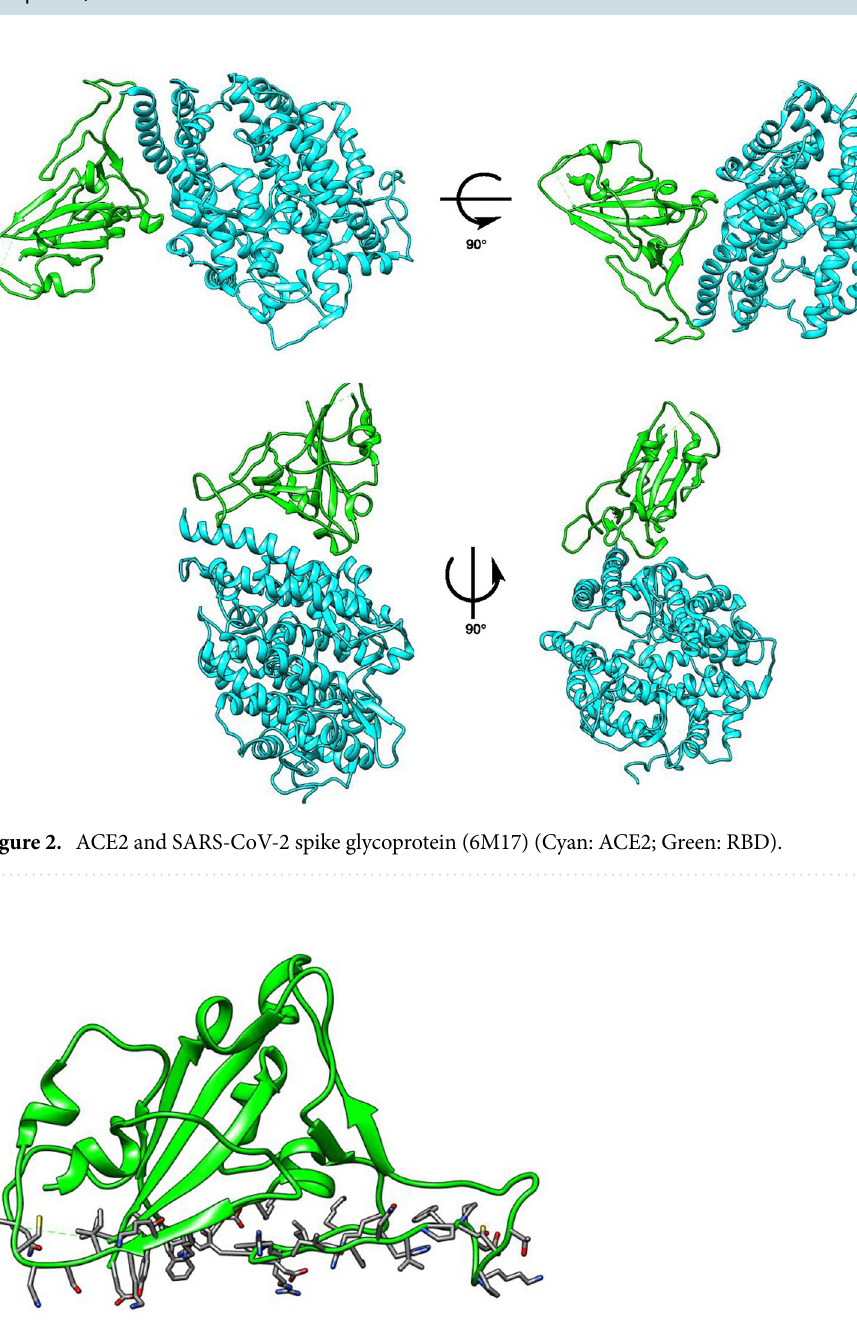
Figure 3. Receptor binding domain of SARS-CoV-2 spike